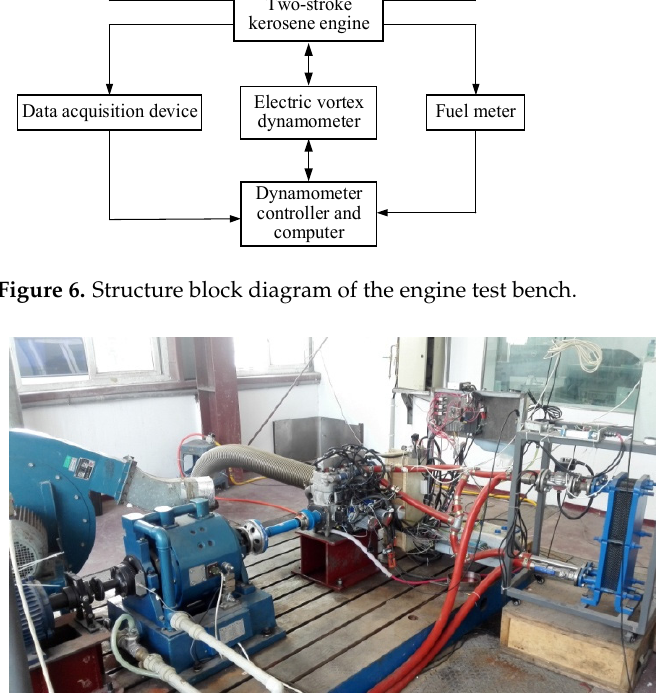
Figure 7. Engine bench site.